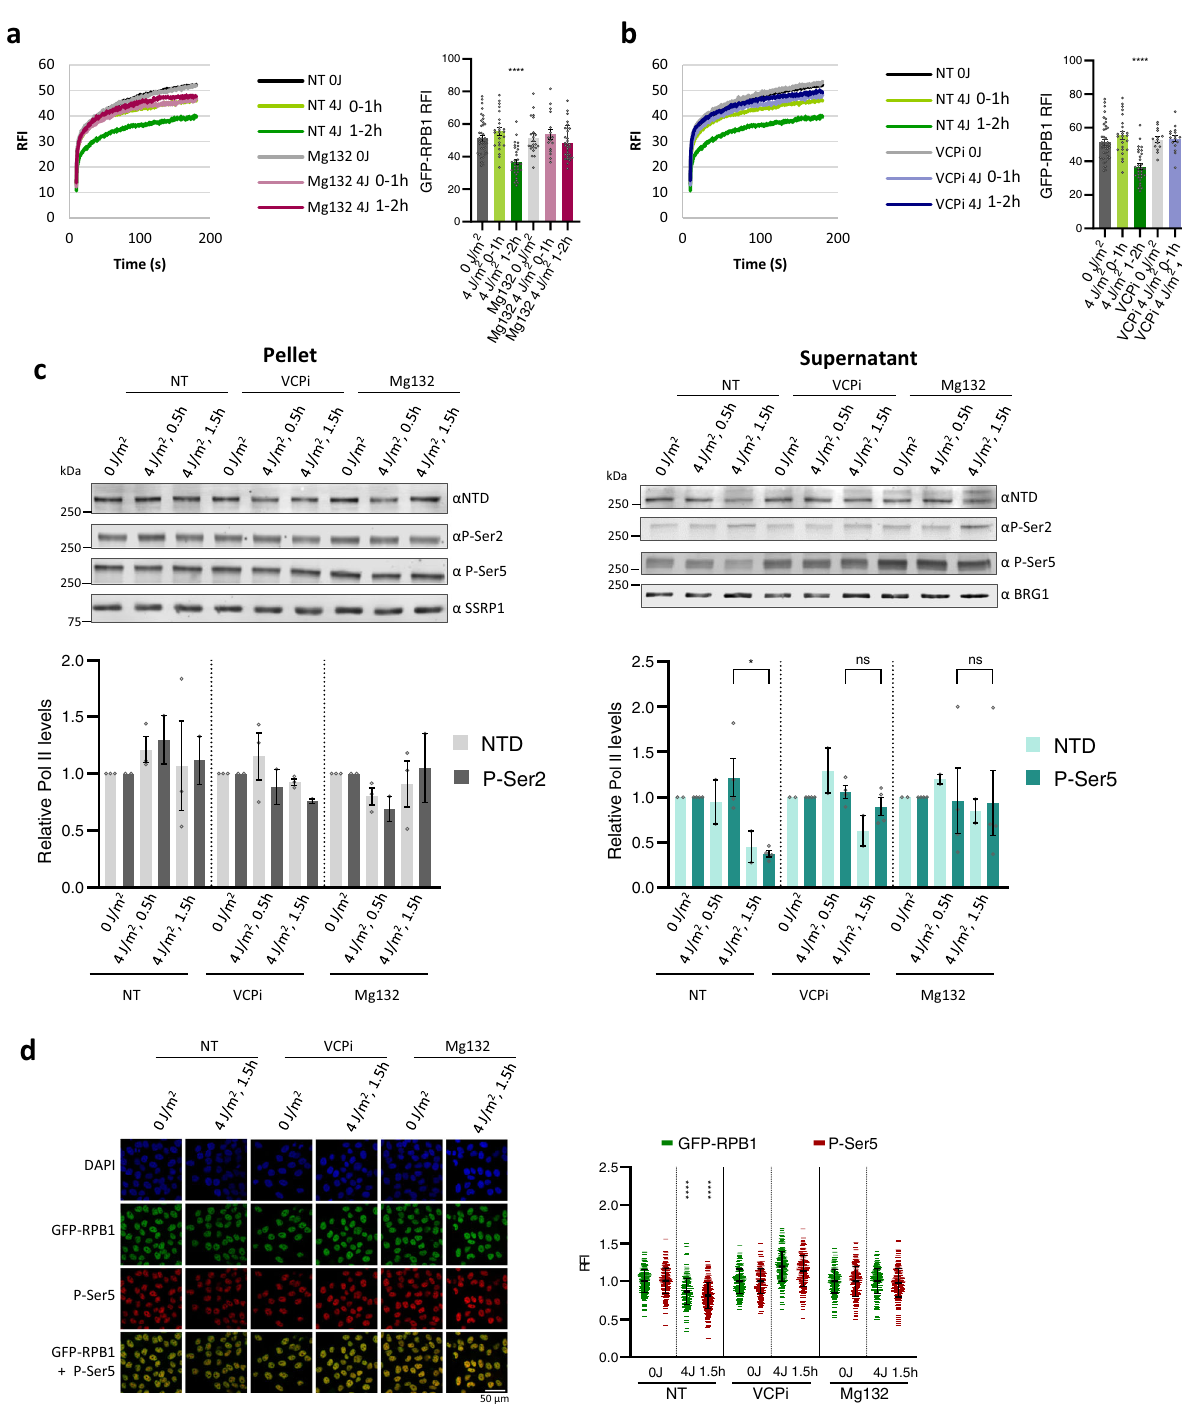
treated cells (NT) Pol II chromatin binding ~100 bp downstream of the transcription start site (TSS) of RPLP1 and RPL3 was not affected directly after UV, but was strongly reduced 1 h after UV. VCP inhibition fully rescued the UV-induced loss of Pol II pro- moter occupancy (Fig. 3a), in line with the rescue of promoter- bound Pol II protein levels (Fig. 2b, c). In contrast to VCP inhibition, proteasome inhibition did not rescue UV-induced loss of promoter occupancy, while it fully rescued the protein levels of promoter-bound Pol II as assessed in the supernatant fraction after fractionation (Fig. 2a, c). These results indicate that